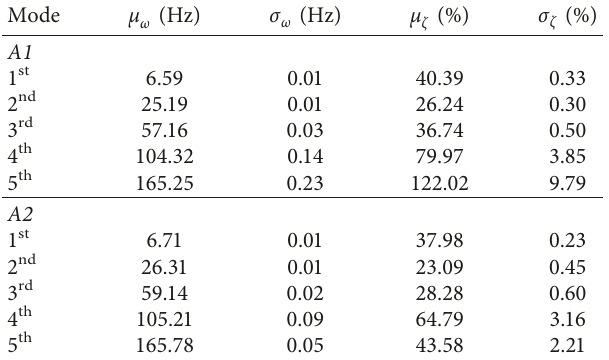
Table 3: Experimental modal results for A3 and A4 configurations 2 (damping rates (10 −